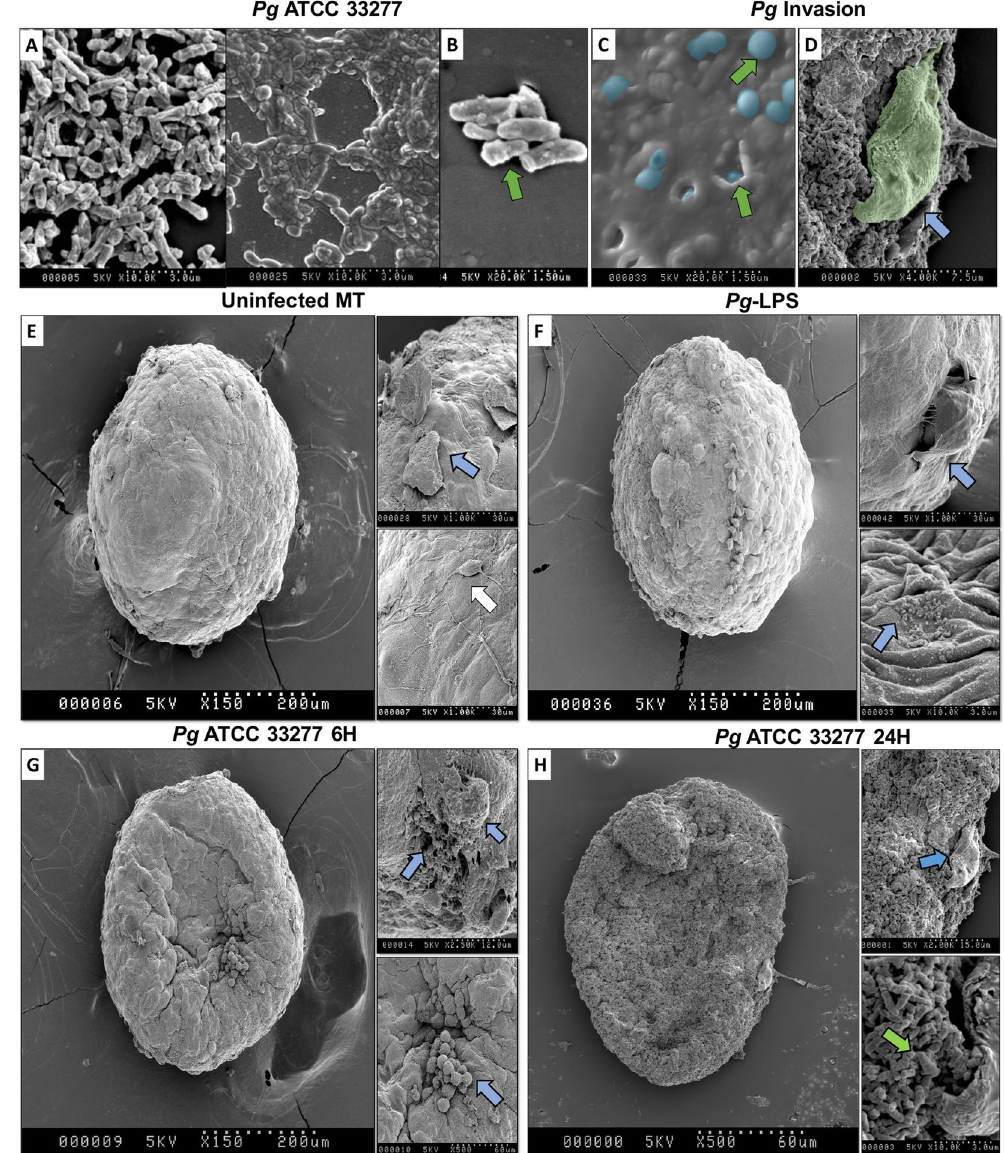
Figure 4. P. gingivalis bypasses the epithelial barrier to reach FBs located at the core of the MT leading to MT destruction. SEM imaging of ( A , B ) P. gingivalis culture, ( C ) P. gingivalis infection and intracellular invasion of the MT surface, ( D ) P. gingivalis proliferating on MT surface and EC exfoliation, ( E ) uninfected MT, ( F ) MT stimulated with LPS, ( G ) MT infected with P. gingivalis for 6 h and ( H ) for 24 h. Green arrows indicate P. gingivalis infection in MT and/or cell invasion; blue arrows indicate the disruption of epithelial barrier, multiple apoptotic cells and an acute cellular injury in all strata of the MT – EC and FB-; white arrow indicates proliferating EC at the surface of